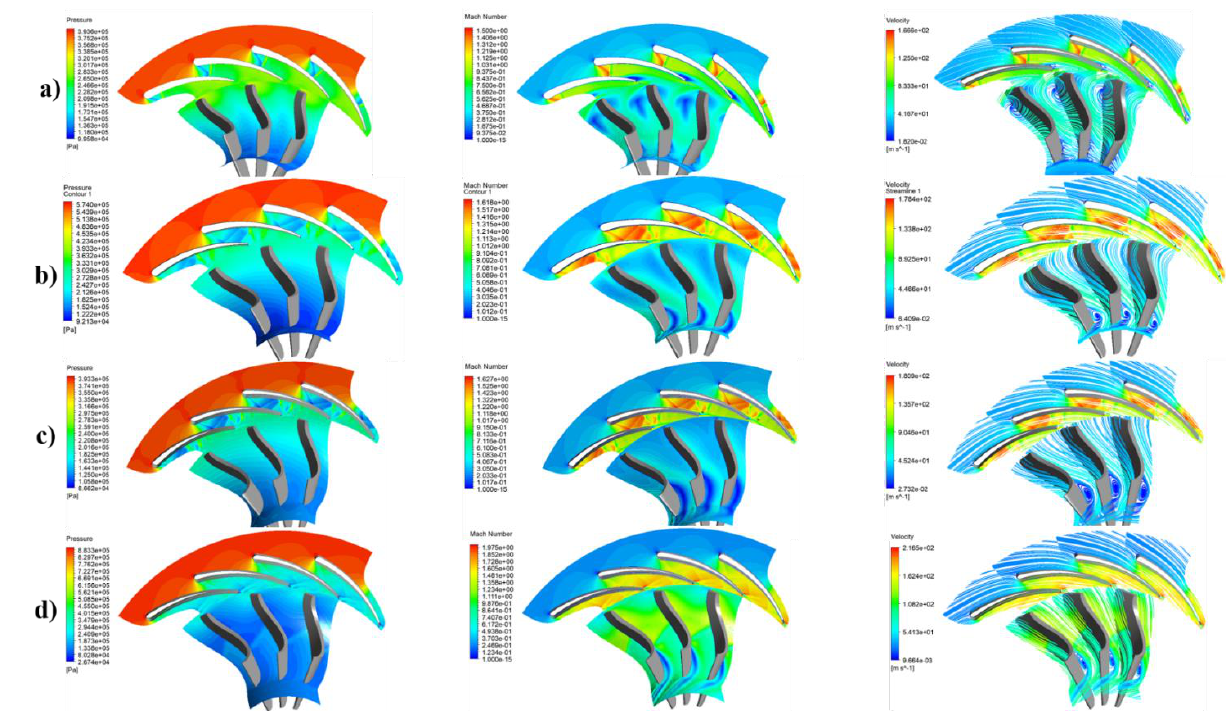
Figure 22. Pressure distributions, Mach numbers, and velocity streamlines at 50% span and 471.55 K, for ( a ) PR = 3, N = 40,000 rpm ( b ) PR = 4.5, N = 40,000 rpm ( c ) PR = 3, N = 30,000 rpm and ( d ) PR = 6.9, N = 30,000 rpm.